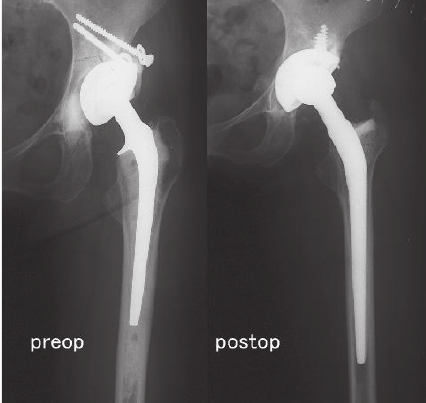
Figure 2: A 54-year-old woman underwent primary THA for osteoarthritis of the hip. Eleven years later, revision THA was performed using the ROBODOC system due to aseptic loosening. Full weight bearing was possible within 1 week after surgery. At the latest follow-up, 9 years postoperatively, no clinical or radiographic problems were